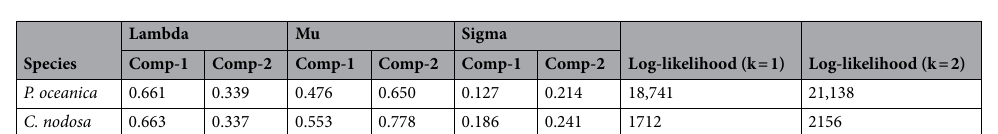
Figure 1. Density plots of CpG O/E values from gene bodies of the seagrasses P. oceanica (left panel) and C. nodosa (right panel). Black dashed lines represent the unimodal CpG O/E distribution, whereas the green and red solid lines represent low-CpG O/E and high-CpG O/E components respectively, as derived from the bimodal distribution provided by the 2-component Gaussian model. Dotted vertical lines indicate the intersection of the two fitted component curves.